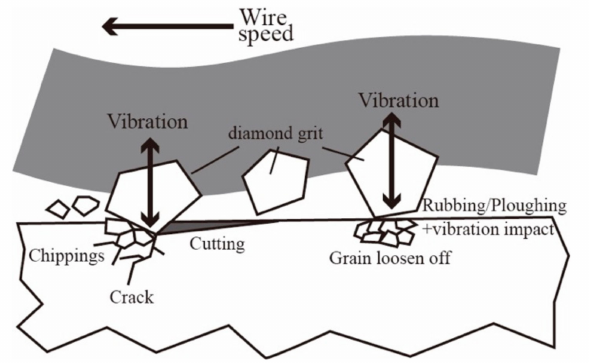
Figure 13. Two different mechanisms for the surface formation during diamond wire sawing of the NdFeB magnet considering the